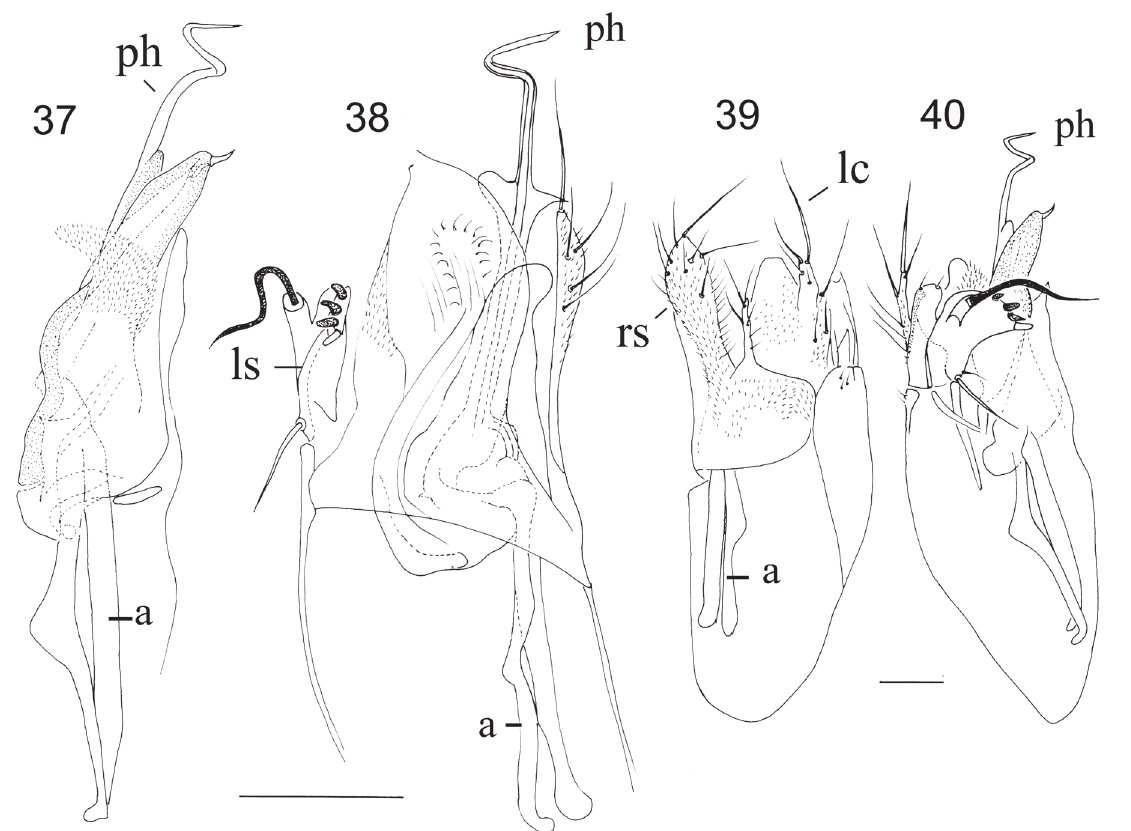
Figs 37-40. Chersodromia flavicaput Grootaert, Cumming & Shamshev, 2007, ♂ terminalia. 37 . hypandrium with phallus, ventral view. 38 . tip of hypandrium, ventral view. 39 . epandrium with cerci, dorsal view. 40 . left epandrial lamella and hypandrium, lateral view. Scale bars = 0.1 mm (after Grootaert et al.